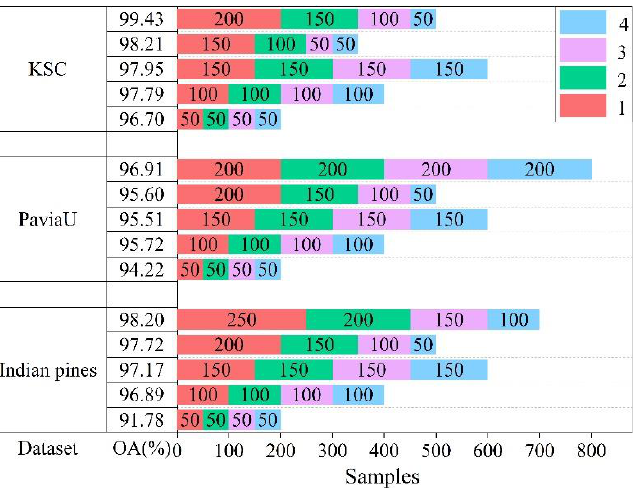
Figure 7. Five experiments were performed on three datasets to determine the number of samples selected for each round of active learning strategies.